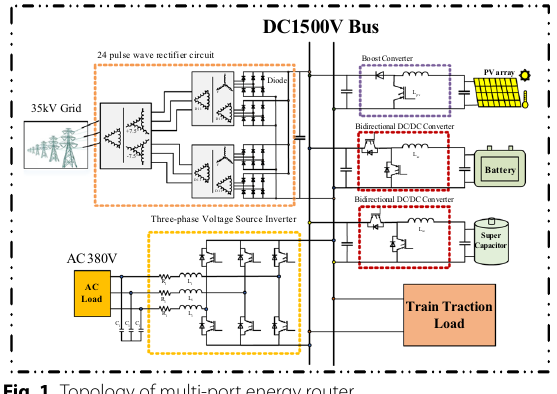
Fig. 1 Topology of multi-port energy